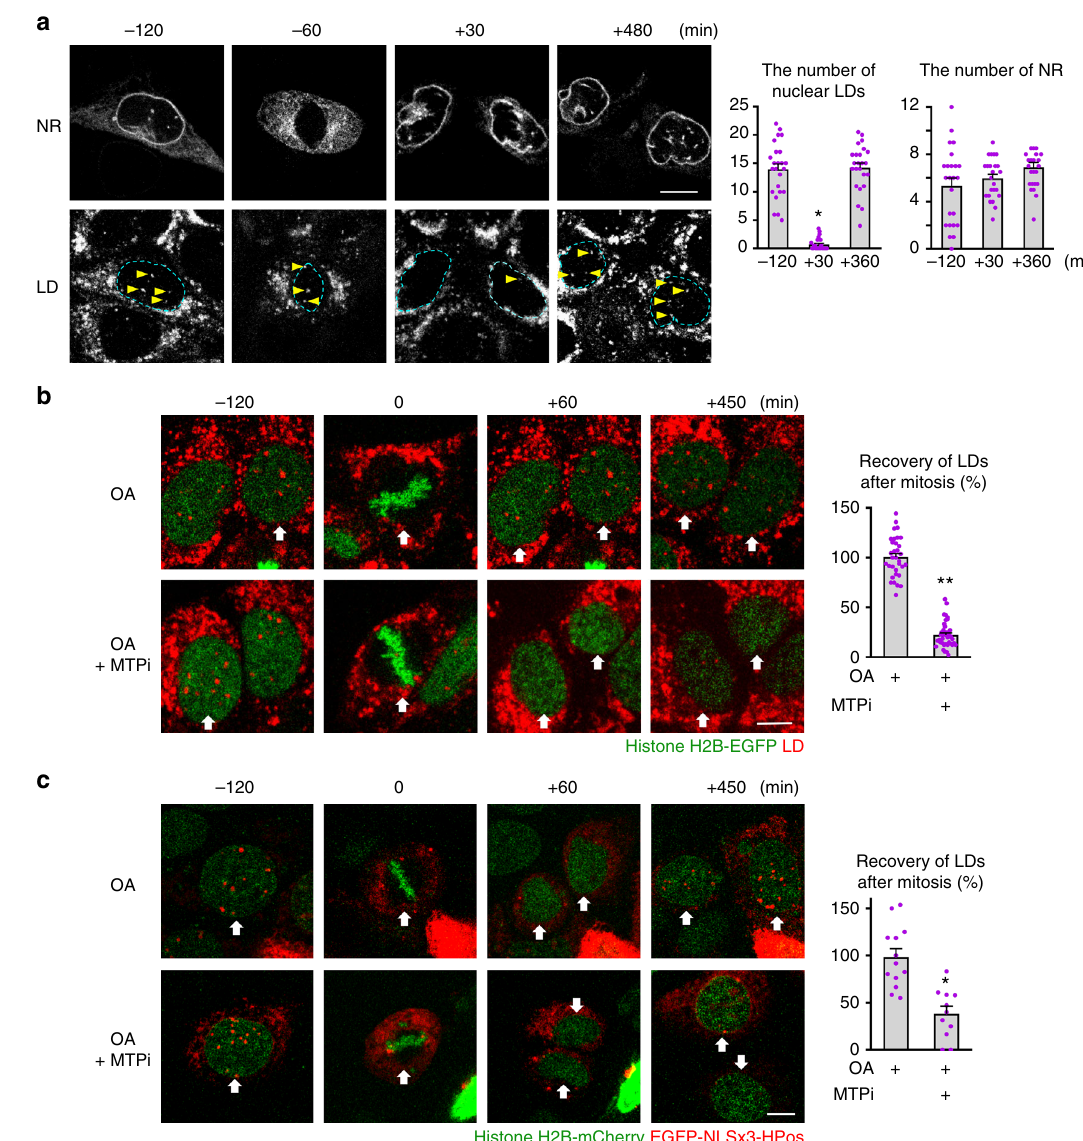
Fig. 5 Nuclear LDs regenerate in post-mitotic cells in an MTP-dependent manner. a Huh7 preincubated with OA for 24 h was tracked in the same medium. Selected frames from Supplementary Movie 4. LDs (LipidTox Red, arrows), INM and NR (EGFP-LBR). Nuclear LDs and the NR were counted 2 h before mitosis, and 0.5 h and 6 h after mitosis (0 min = the time point of nuclear envelope reformation). Mean± SEM of 24 mitotic events. * p < 0.01, Friedman test followed by Dunn – Bonferroni test. The lack of difference in the NR was veri fi ed by repeated measures ANOVA. b Huh7 preincubated with OA for 24 h was tracked in the same medium with or without 100 n M BAY 13-9952. Selected frames from Supplementary Movie 5. LDs (red, LipidTox Red), chromatin (green, histone H2B-EGFP). The number of nuclear LDs before mitosis and 6 h after mitosis was counted (0 min = the time point that cells of interest entered the metaphase). Mean± SEM of 33 (OA) and 40 (OA and BAY 13-9952) mitotic events. * p < 0.01, Student ’ s t test. c Huh7 preincubated with OA for 24 h was tracked in the same medium with or without 1 μ m BAY 13-9952. Selected frames from Supplementary Movie 6. Nucleoplasmic LDs (red, EGFP-NLSx3-HPoS), chromatin (green, histone H2B-mCherry). Nuclear LDs before mitosis and 6 h after mitosis was counted. Mean ± SEM of 13 (OA) and 11 (OA and BAY 13-9952) mitotic events. * p < 0.01, Student ’ s t test. Bars, 10 μ m. Source data are provided as a Source data fi